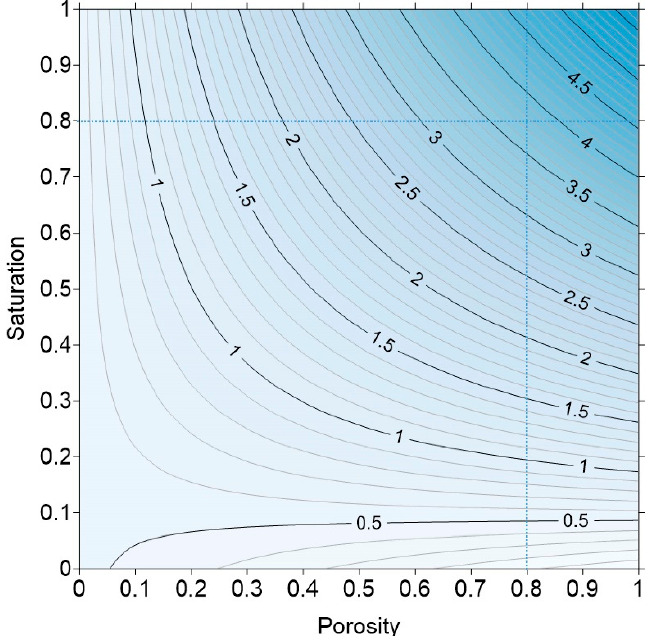
Figure 8. Effective linear attenuation coefficient µ e as a function of porosity and water saturation. The Figure 8. E ff ective linear attenuation coe ffi cient µ e as a function of porosity and water saturation. dotted blue lines indicate the 80% values. The dotted blue lines indicate the 80%